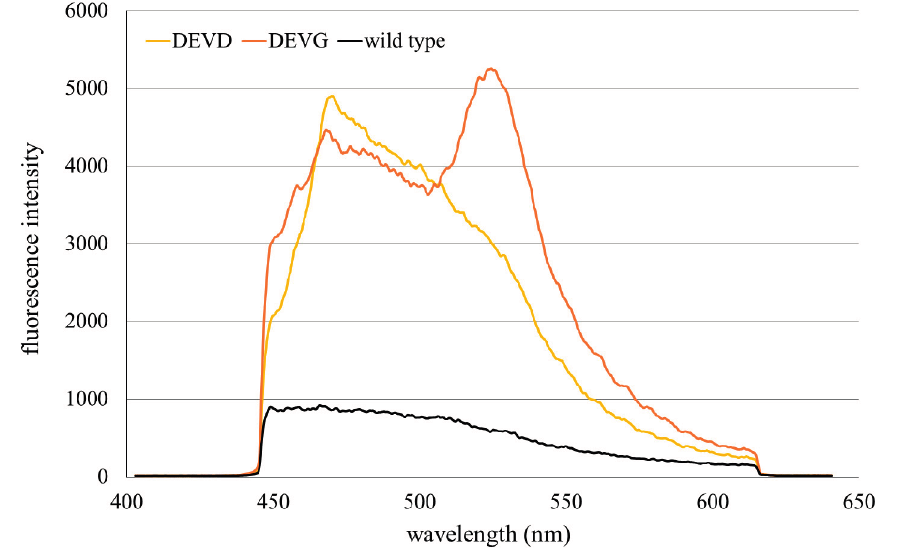
Figure 2. Fluorescence spectra of spheroids of HeLa cervical carcinoma cells transfected with the Mem-enhanced cyan fluorescent protein (ECFP)-DEVG-enhanced yellow fluorescent protein (EYFP) or the Mem-ECFP-DEVD-EYFP encoding vector in comparison with autofluorescence of non-transfected HeLa cells (“wild type”) after application of staurosporine (2 µM, 2.5 h); excitation wavelength: 405